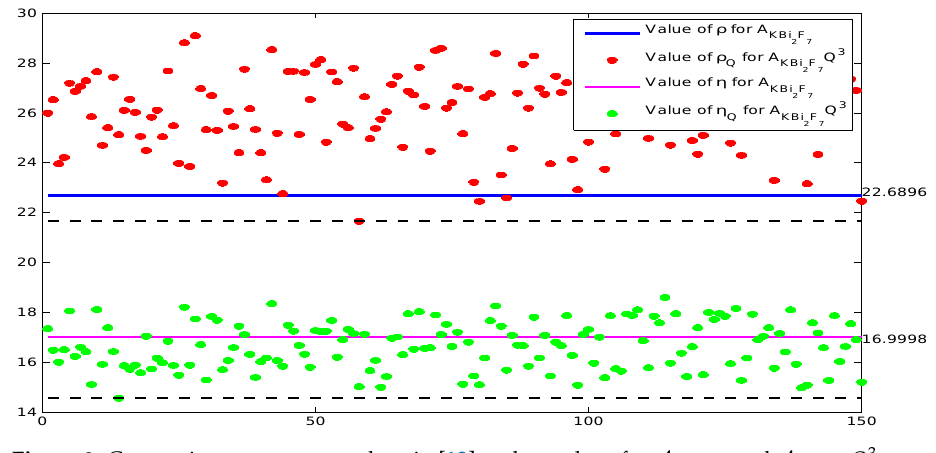
Figure 2. Comparisons among ρ and ρ Q in [12] and η and η Q for A KBi